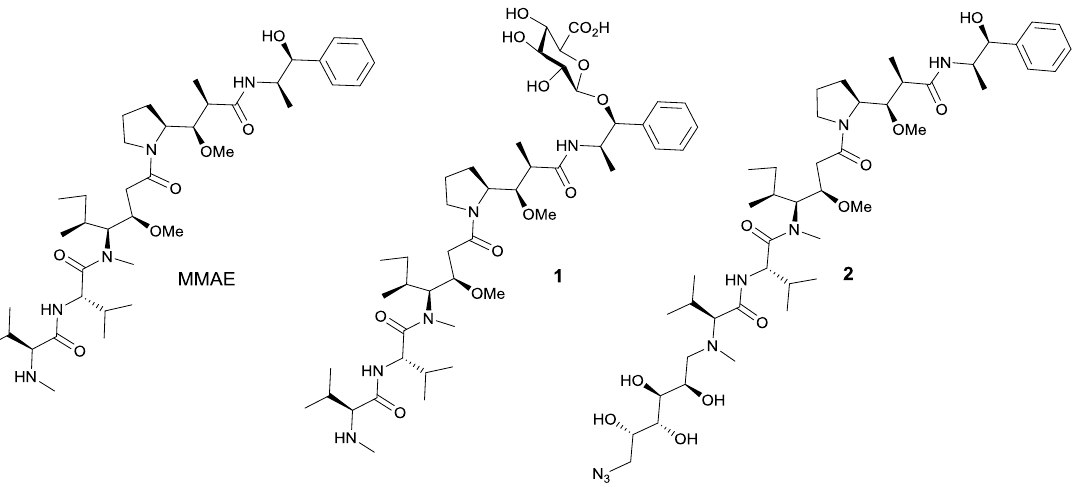
Figure 1. Chemical structures of the cytotoxic agents studied: from the left; monomethyl auristatin E (MMAE), 1 (β-d-glucuronyl-monomethylauristatin E, MMAU), and 2 (MMAE-glycolinker-substrate).